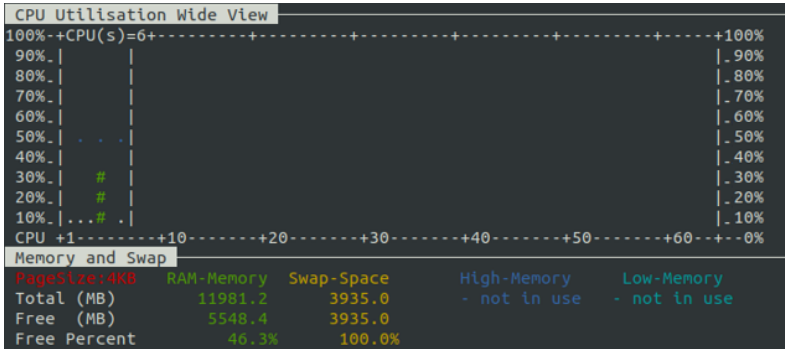
Figure 9. CPU and memory usage in the VM hosting the OneM2M platform.